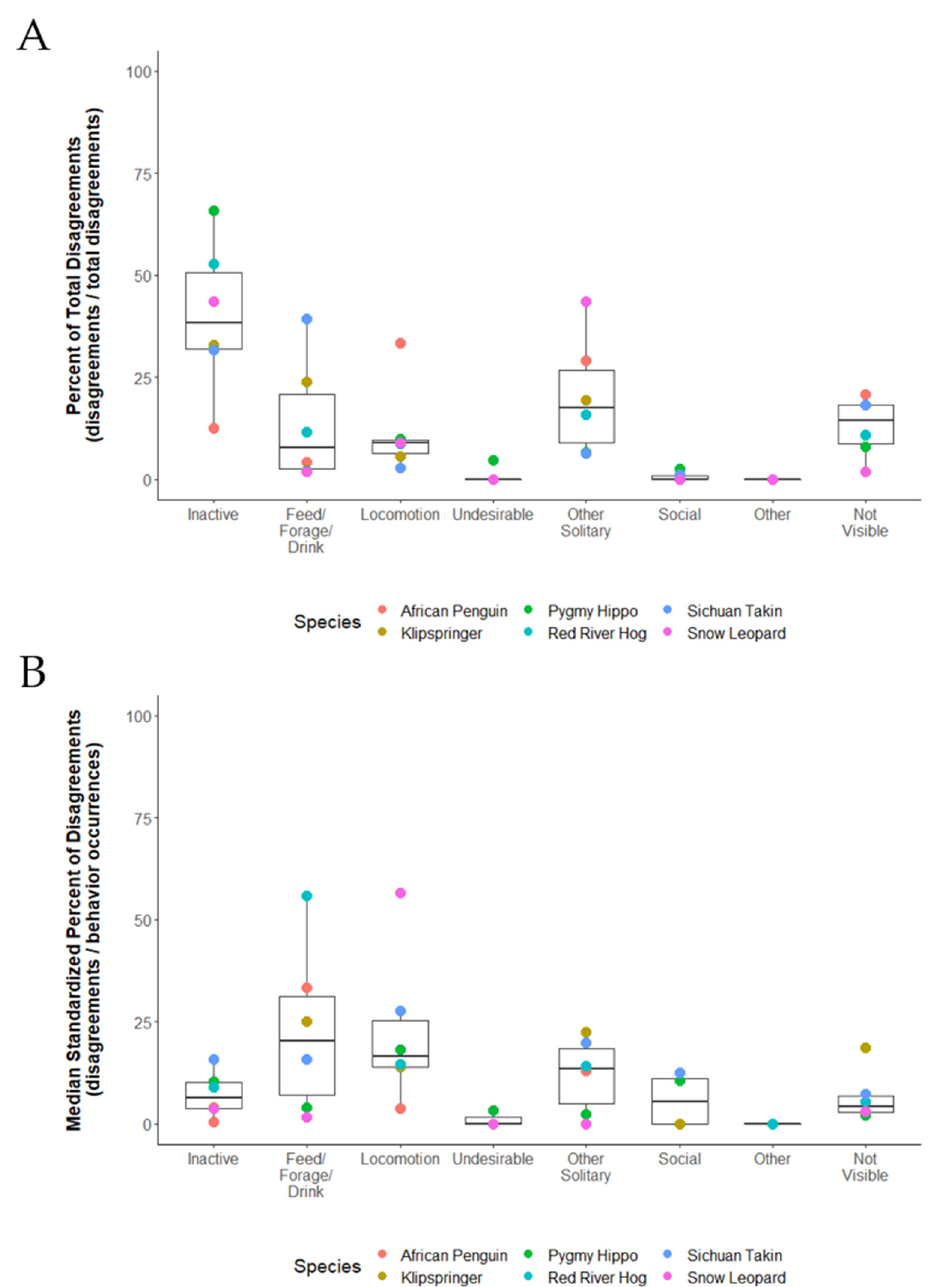
Figure 5. The disagreements observed during inter-observer reliability tests for each behavior category of the six study species. The ( A ) percent of total disagreements observed, and ( B ) median standardized percent of disagreements are shown to demonstrate the overall pattern of disagreements and the pattern of disagreements when adjusting for how frequently a behavior occurred. Points representing species values are superimposed over boxplots depicting the median (line), inter-quartile range (box), and min and max values (whiskers) across